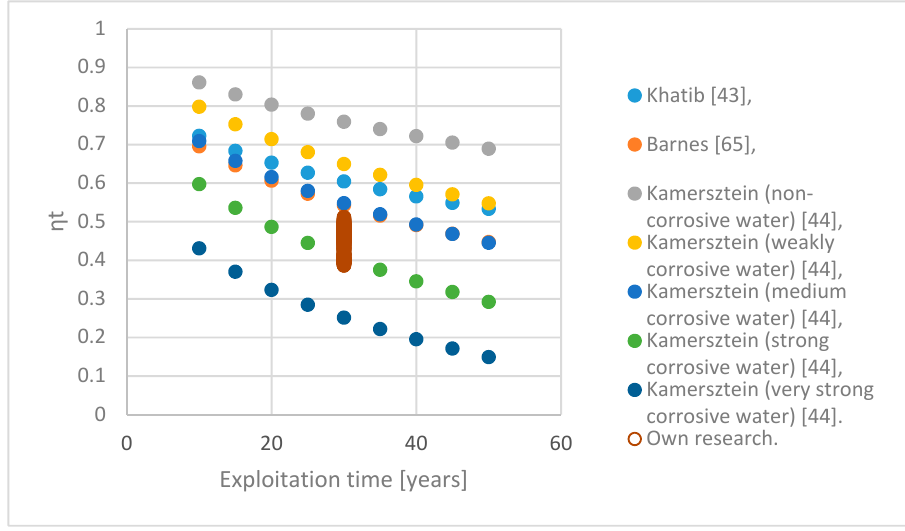
Figure 12. Flowability drop of the investigated pipes after 30-year exploitation, compared to the literature data.